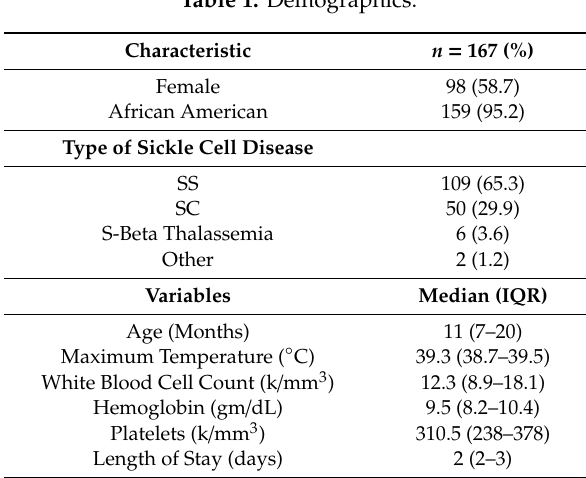
Figure 1. Study population. SCD: sickle cell disease.